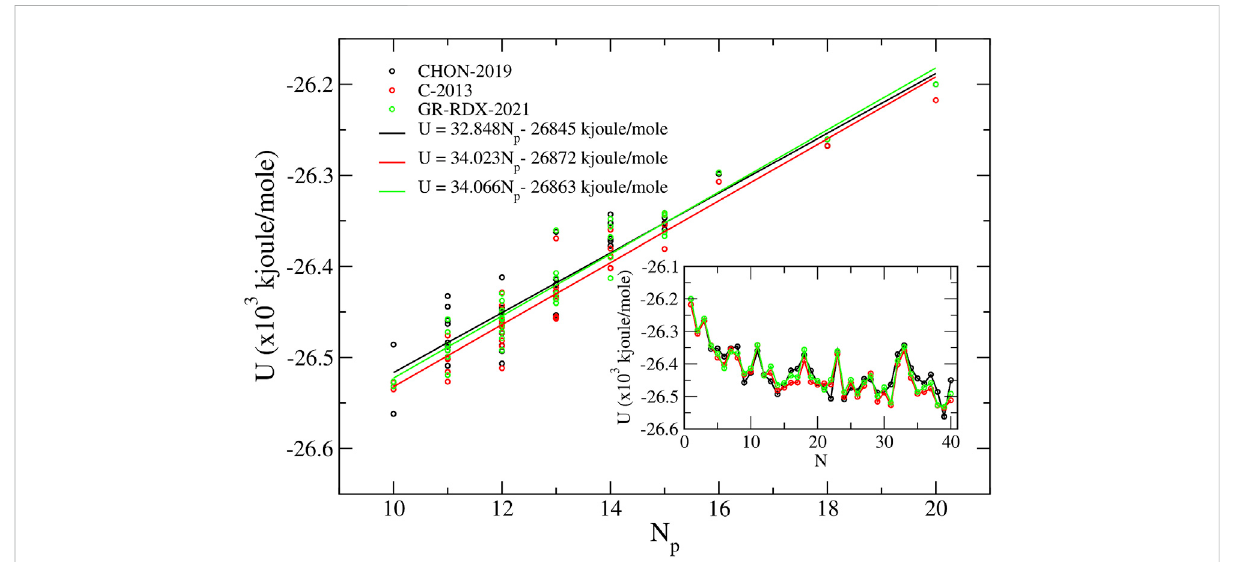
FIGURE 13 Binding energy U of the 40 C 40 fullerene isomers vs . the pentagon adjacencies N p calculated using the three ReaxFF potentials. In the inset, we show the calculated energy values versus the standard C 40 isomer enumeration (Fowler and Manolopoulos